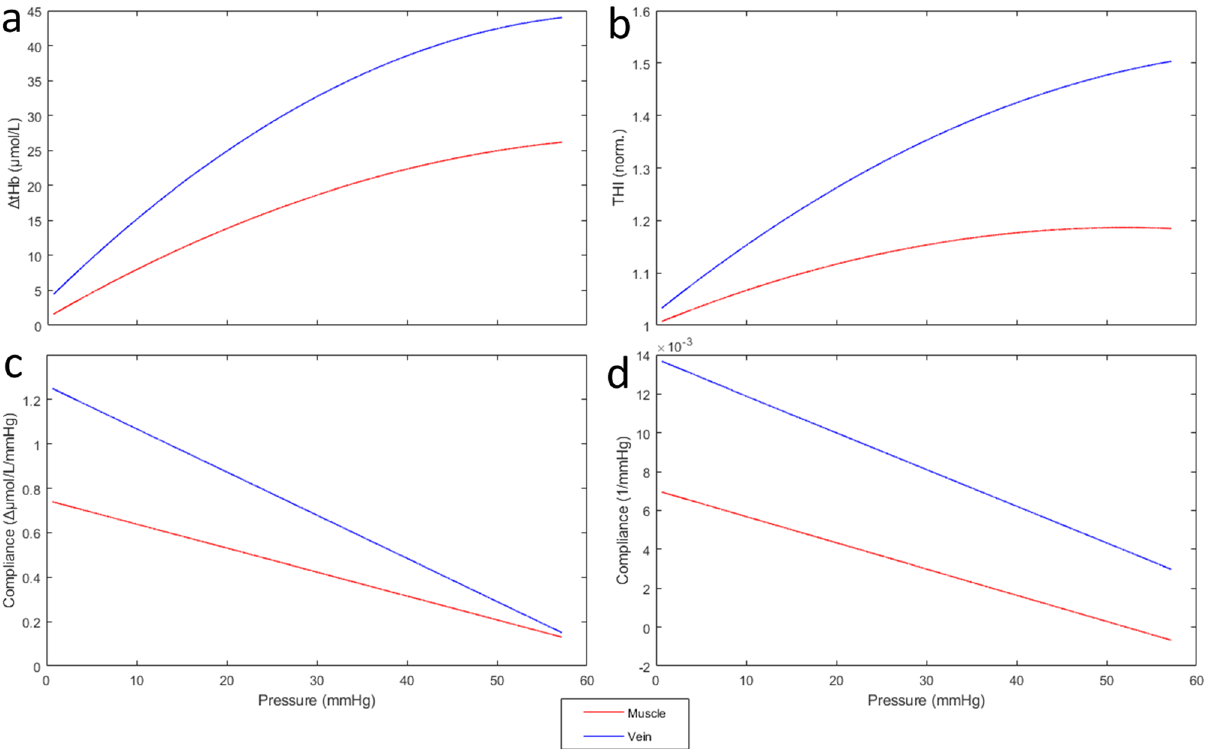
Figure 3. Volume-pressure curves, obtained by 2° order polynomial fitting of average responses to slow cuff- deflation of Fig. 2a (top), and compliance curves, obtained as the slopes of the corresponding volume-pressure curves (bottom), for tHb (left) and THI (right) collected from vein (blue) and muscle (red). Note the large difference in the compliance estimated from vein and